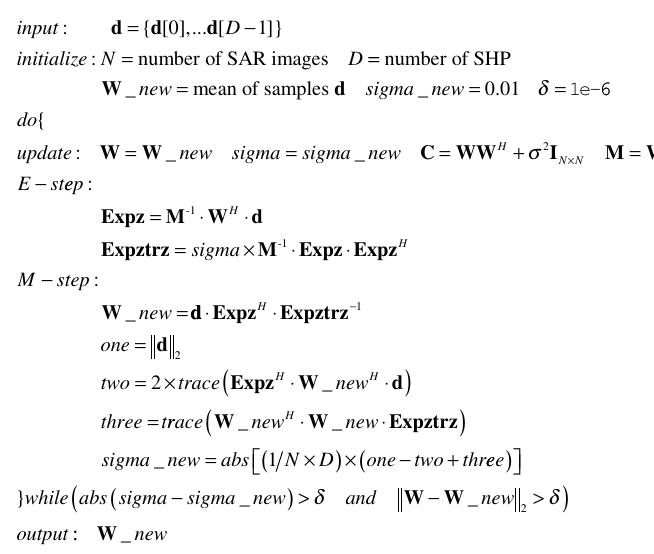
Figure 1. The pseudo-codes of the proposed